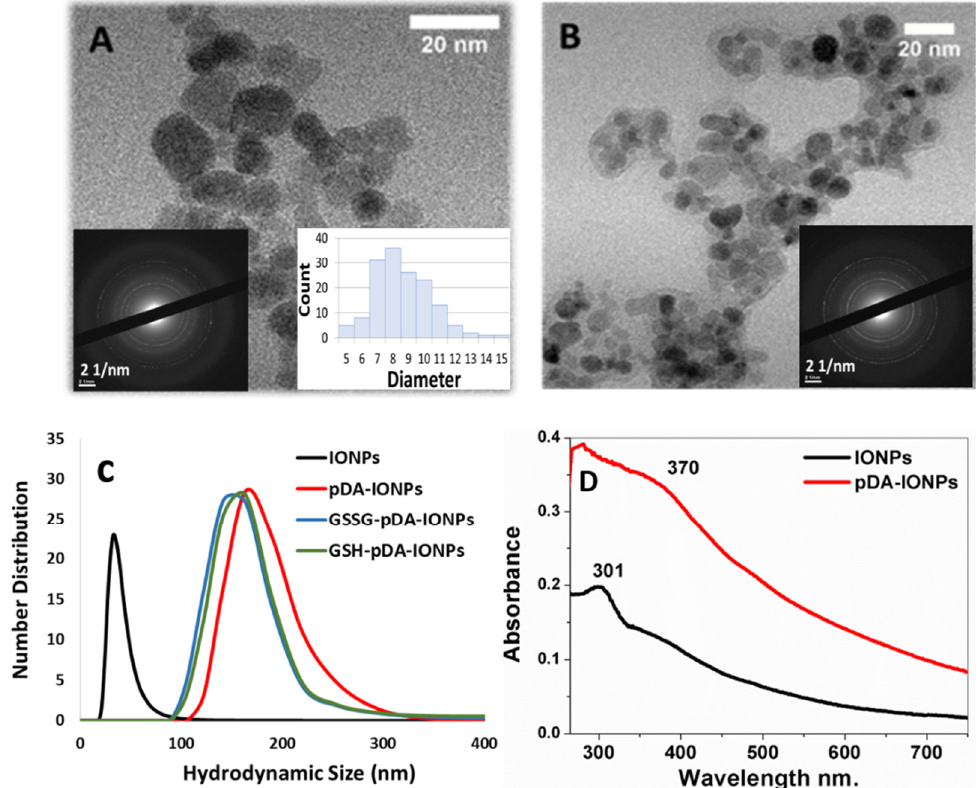
Figure 1. Transmission electronic microscope (TEM) images of ( A ) bare IONPs; and ( B ) pDA-coated IONPs (inset selected area (electron) diffraction (SAED) patterns and size distribution); ( C ) Dynamic light scattering (DLS) measurements showing the hydrodynamic diameter at pH = 5.0–6.0 and in 10 −2 M NaCl; and ( D ) UV-vis spectra of the synthesized nanoparticles.